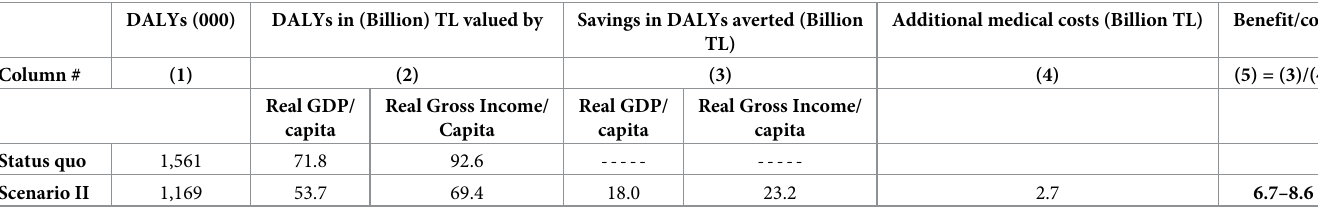
Table 9. Predicted costs and benefits of hypertension management in 2030. DALYs (000) DALYs in (Billion) TL valued by Savings in DALYs averted (Billion